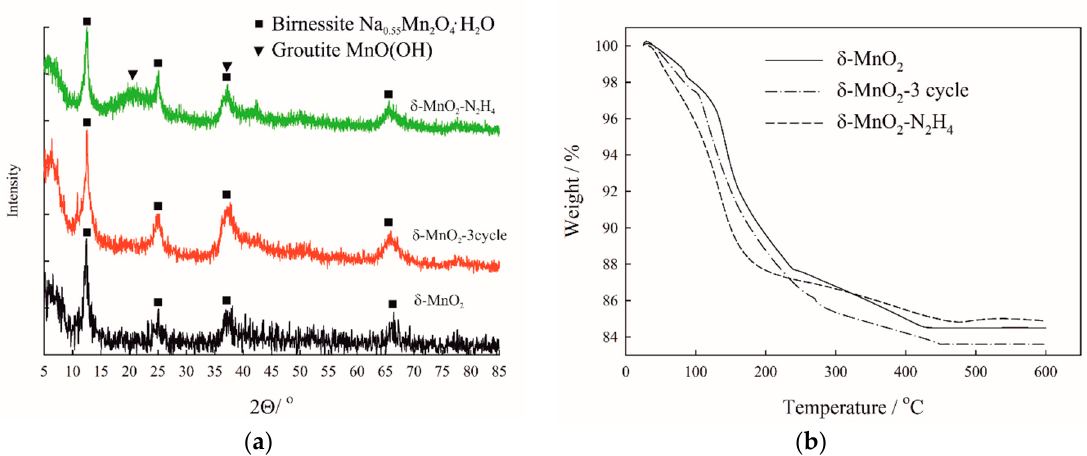
Figure 1. XRD patterns of investigated materials ( a ) and their thermal gravimetric analysis (TGA) curves ( b ).